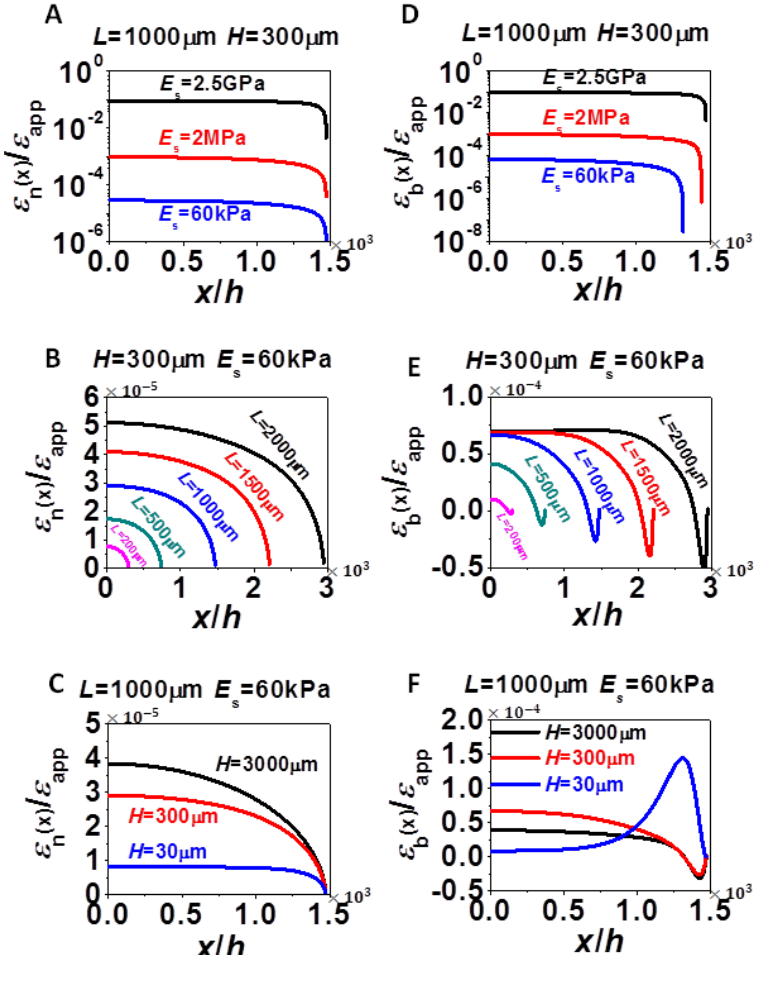
and ε for different L , H , and E n b when L = 1,000 µm and H = 300 µm are fixed. ( B ) Normalized ε s = 60 kPa are fixed. ( C ) Normalized ε s = 60 kPa are fixed. ( D ) Normalized ε s = 60 kPa are fixed. ( F ) Normalized ε s = 60 kPa are s